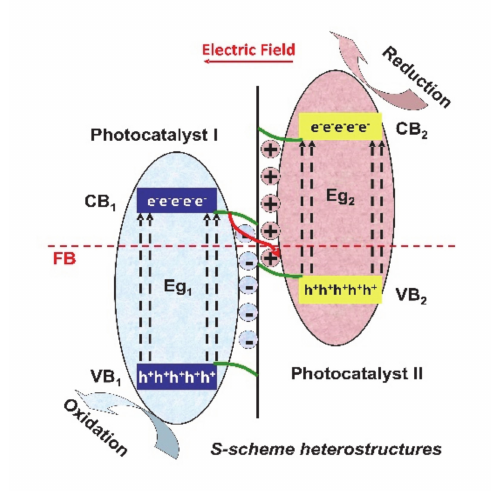
Figure 6. The mechanism of S-scheme